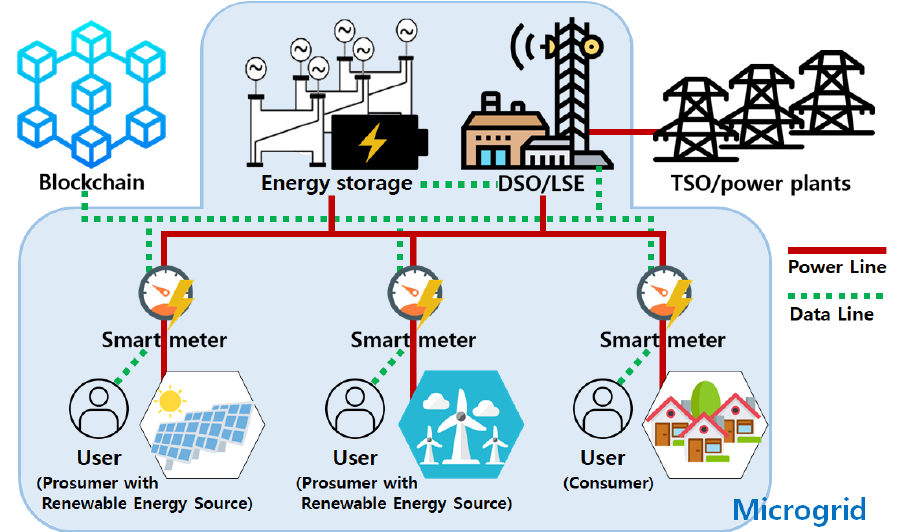
Figure 1. Proposed blockchain-enabled microgrid system model. DSO = distribution system operator; LSE = load serving entity; TSO = transmission system